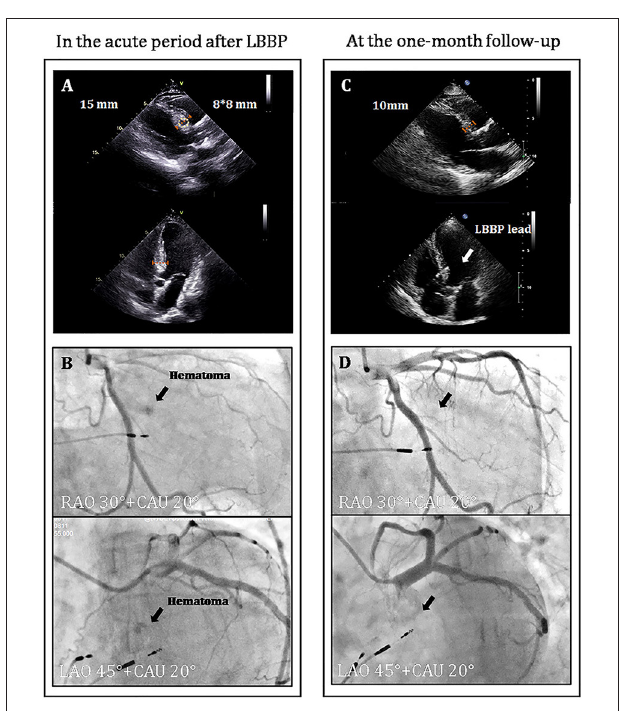
FIGURE 3 | (A) The echocardiogram indicated interventricular septal hematoma measuring 8mm in width. (B) Contrast agent retention in the interventricular septum. (C) The echocardiography confirmed the hematoma has resolved. (D) No contrast agent overflow was found in the interventricular septum. RAO, right anterior oblique; CAU, caudal; LAO, left anterior oblique.